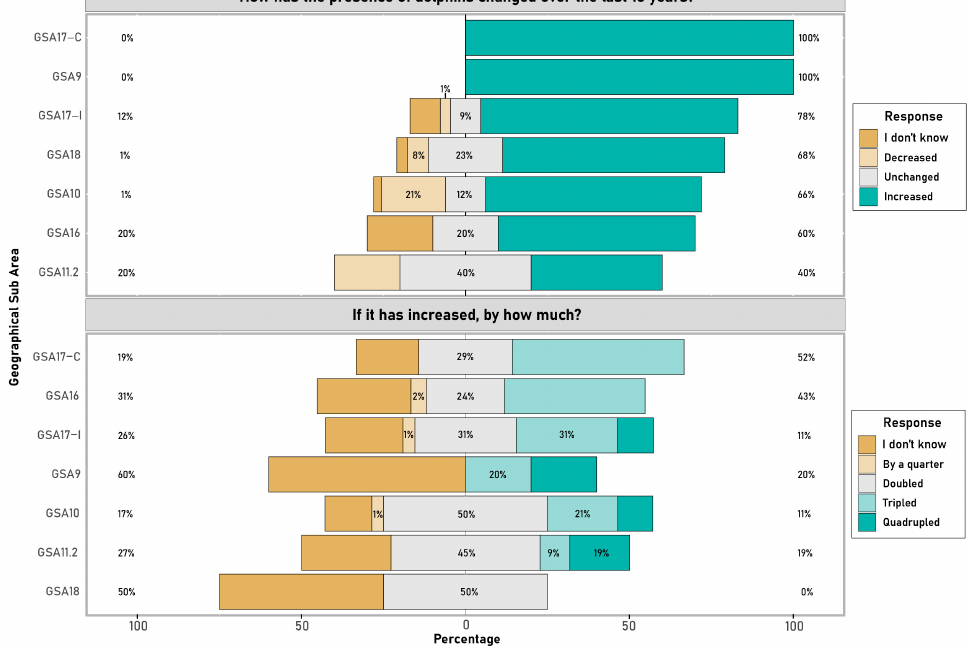
Figure 5. Dolphin population trends in the last 10 years, as perceived by the fishers interviewed. The original questions are shown in bold as the title of each barplot, while the possible responses are included in the corresponding legends.